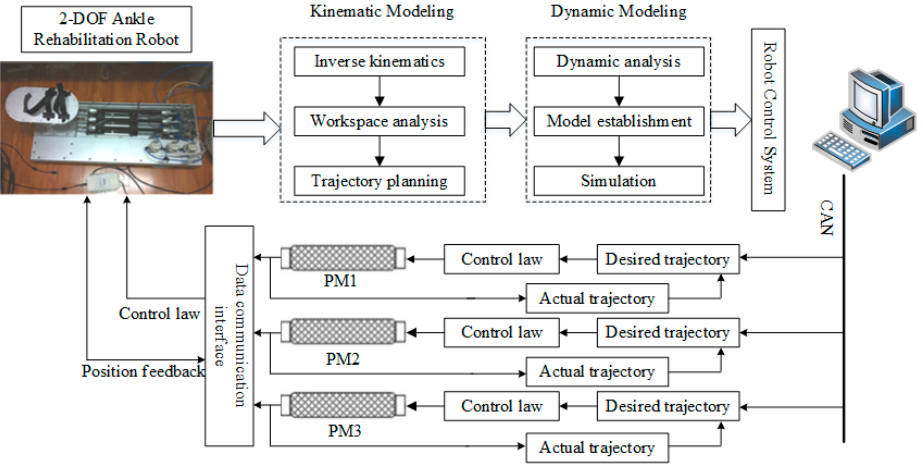
Figure 1. System structure of the ankle rehabilitation robot.